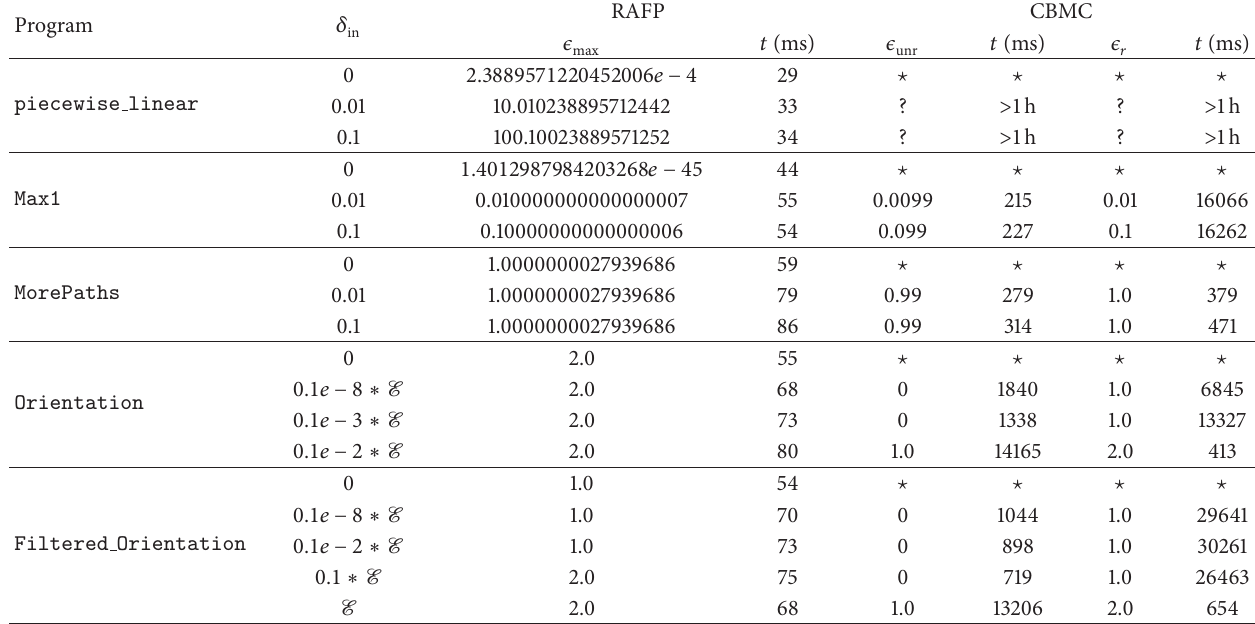
Table 1: Experimental results for benchmark